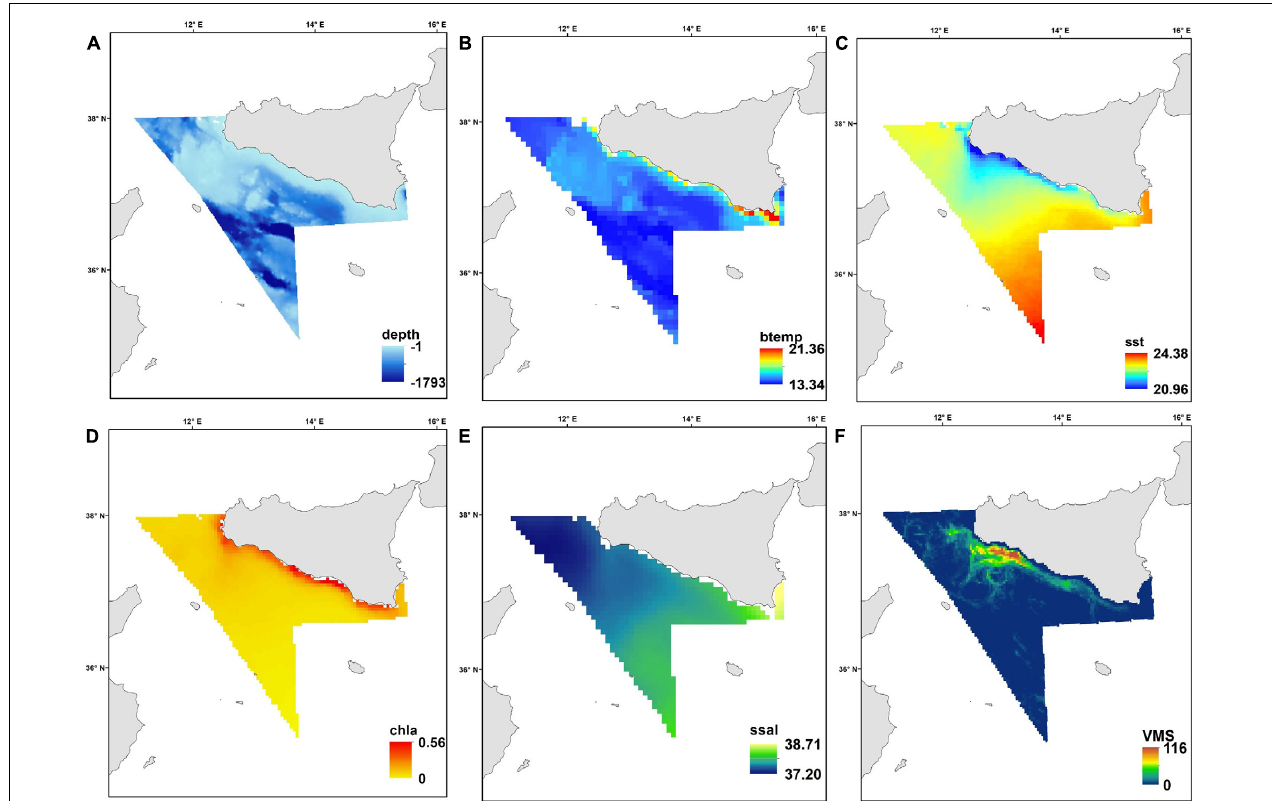
FIGURE 2 | The spatial patterns of the environmental variables as average for the study period (1994–2016): (A) depth (m); (B) bottom temperature ( ◦ C); (C) sea surface temperature ( ◦ C); (D) chlorophyll a (mg/m3); (E) sea surface salinity (PSU), and (F) distribution of the fishing effort in terms of number of fishing hours/year (average